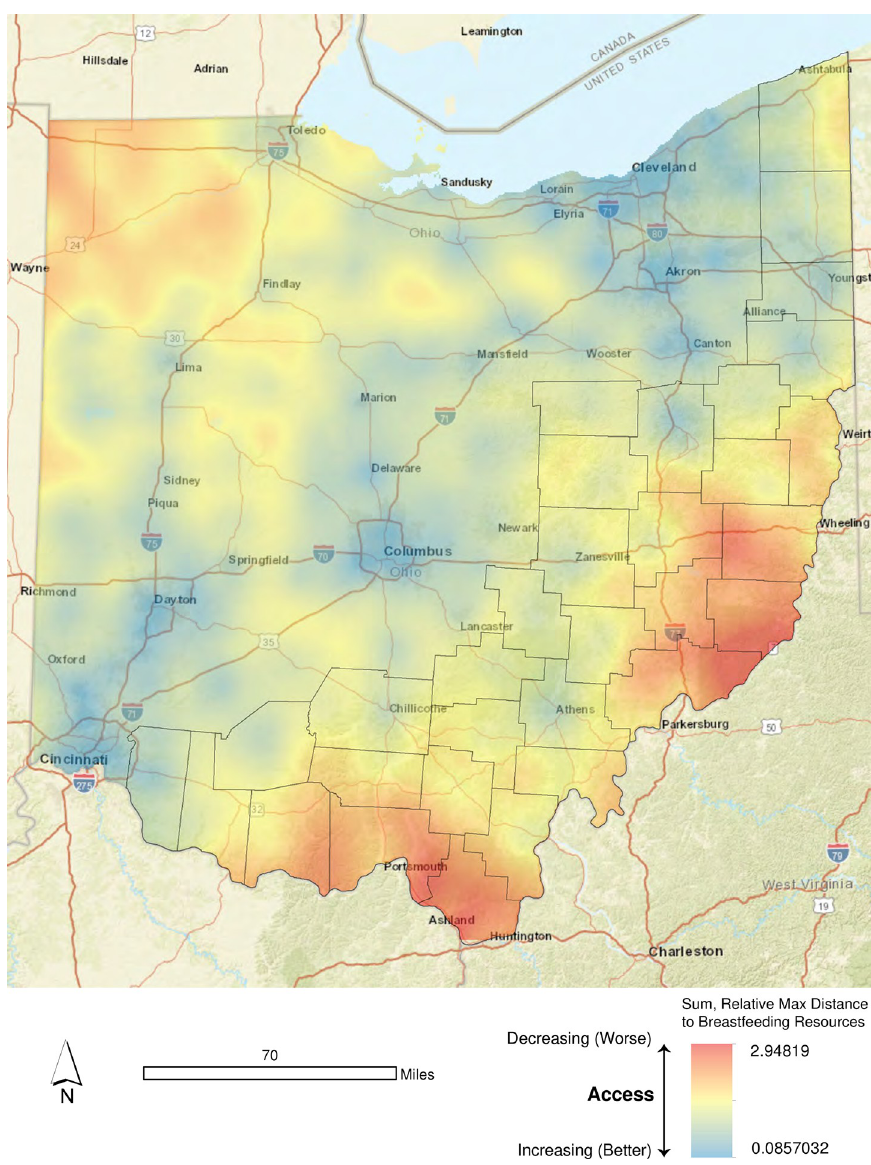
Fig 5. Estimated geographic access to breastfeeding support